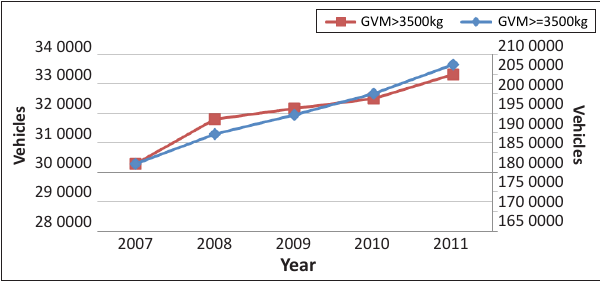
FIGURE 2: Capital investments.